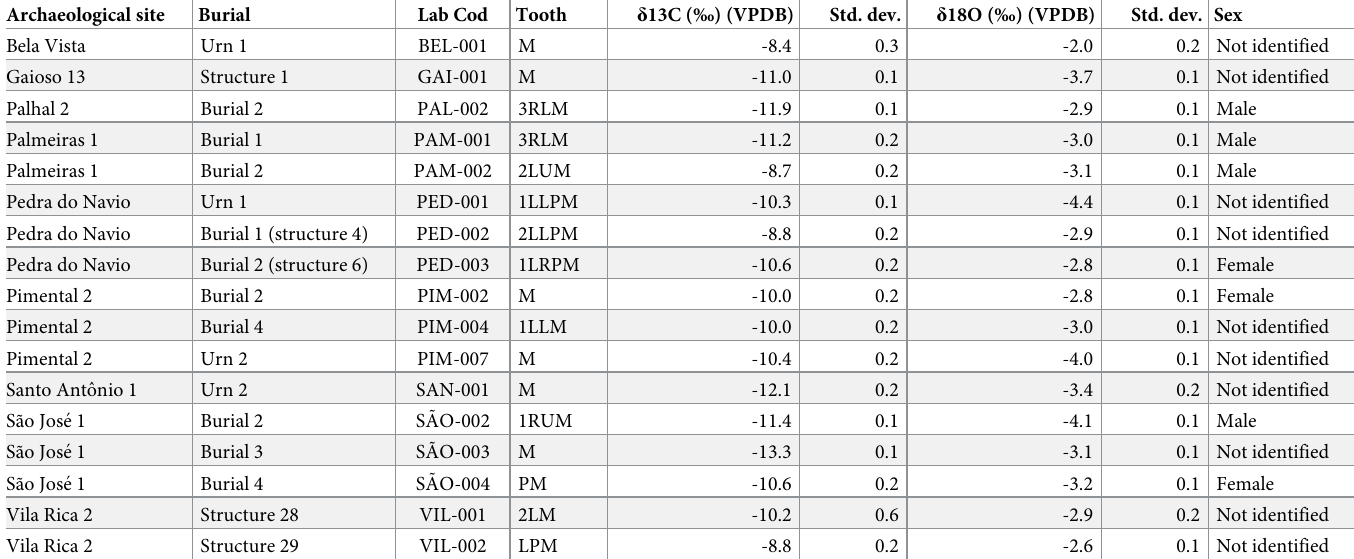
Table 3. δ 13 C ap and δ 18 O values for enamel from prehistoric human from VGRX, archeological sites in the Xingu River Basin, Brazil. Archaeological site